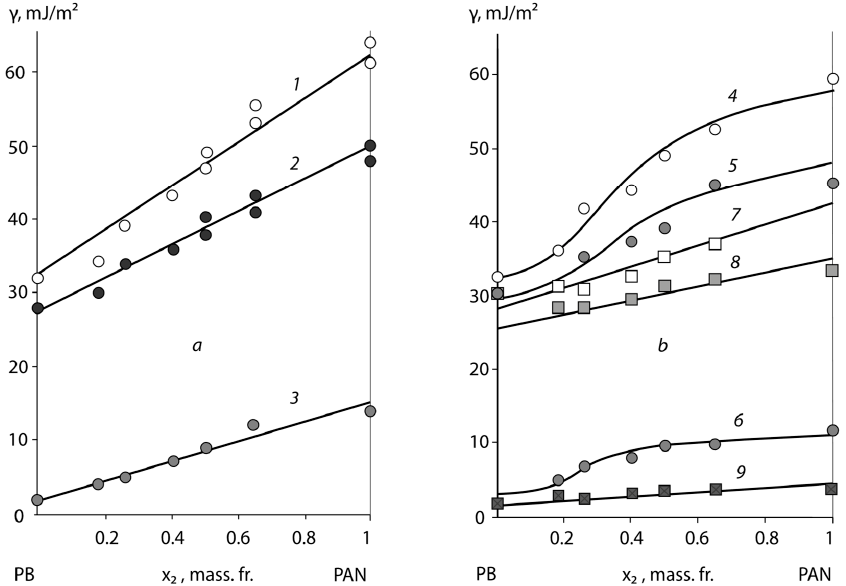
Figure 2. Dependence of the surface energy γ (1, 4, and 7) and its polar γ P (2, 5, and 8) and dispersion components γ D (3, 6, and 9) on the composition of BNC copolymers at 293 ± 1 K. BNC surface is formed on the: ( a ) air — (1, 2, and 3), and ( b ) aluminium — (4, 5,and 6) and PTFE — (7, 8, and 9).